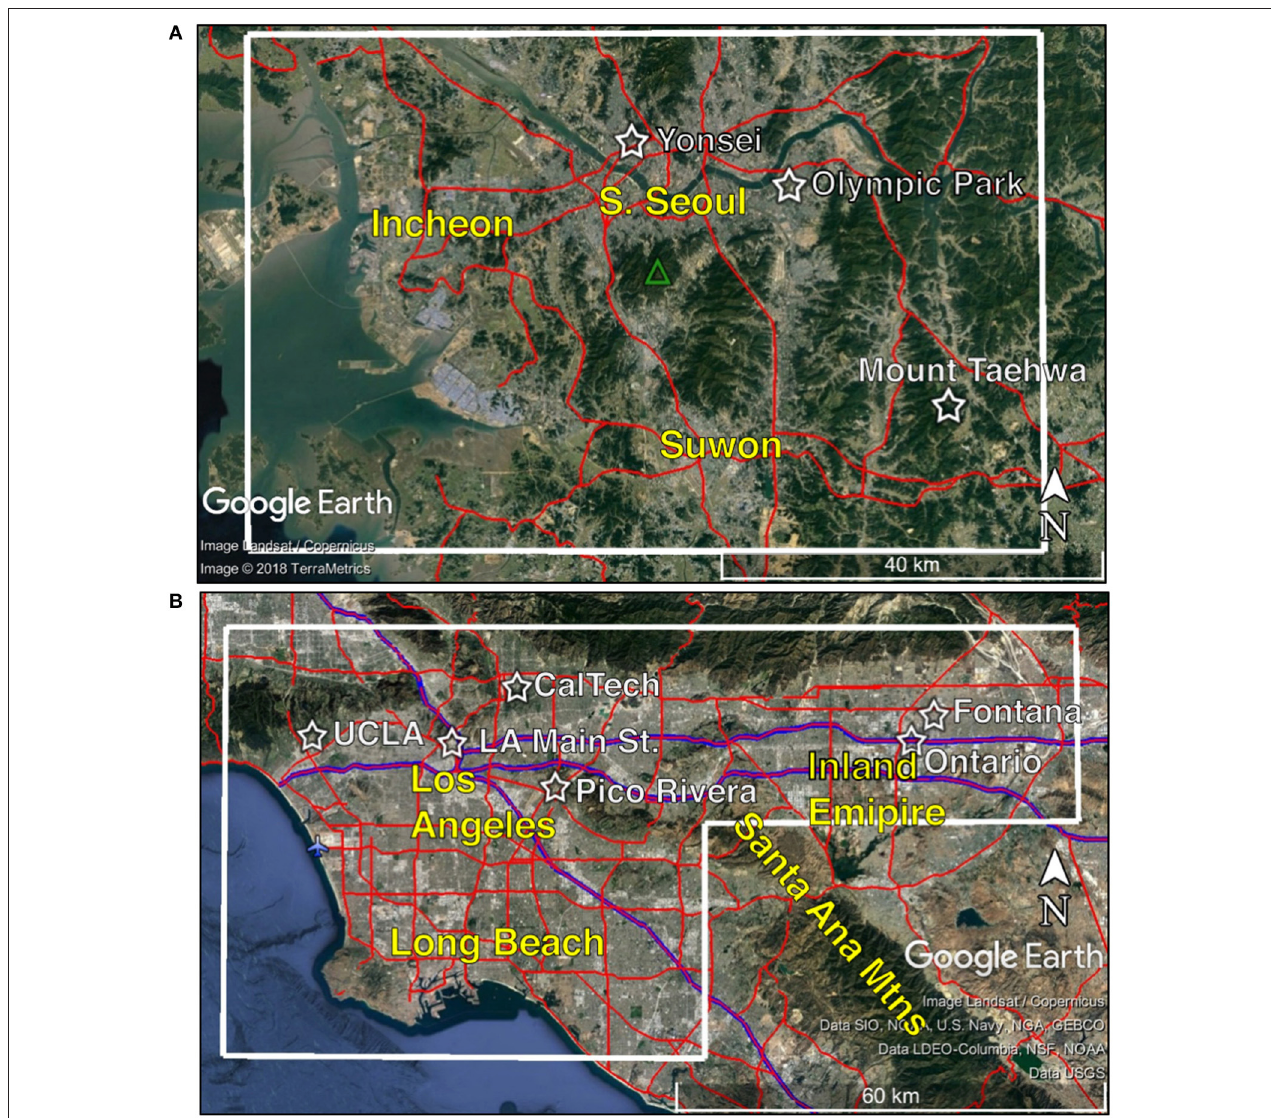
FIGURE 3 | Maps of (A) the SMA and (B) the LA Basin. Major roads (SEDAC (NASA Socioeconomic Data Applications Center) Center for International Earth Science Information Network - CIESIN - Columbia University, 2013) are drawn in red with I-5, I-10, and CA-60 outlined in blue in (B) . Pandora sites are labeled with white star icons, and regions discussed in the paper are labeled in yellow. The green triangle in the SMA is Mount Gwanaksan, and the airplane icon in the LA Basin depicts the location of LAX. GeoTASO rasters cover the approximate area depicted by the white